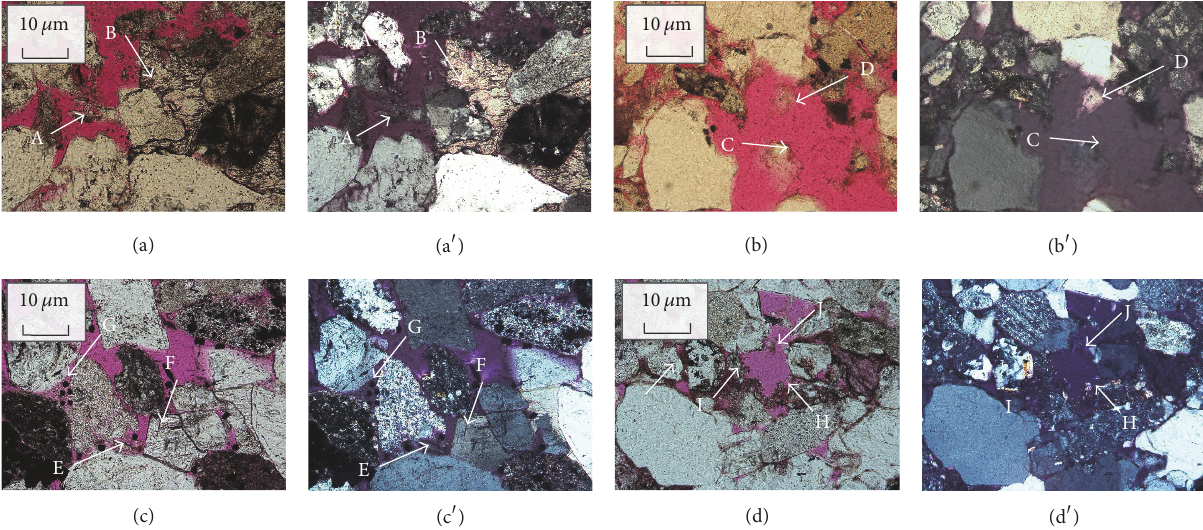
Figure 10: Photomicrographs of pore types by electron microprobe analysis of sandstones in central Junggar Basin. (a) and (a 󸀠 ) Intergranular secondary pore develops, and measuring point A shows that the remnant is K-feldspar and the measuring point B is calcite. The photomicrograph is a red-epoxy-impregnated thin sections of conventional core samples with magnification of 10 (Sha 1 well at 3656.6 m with Jurassic) and photo (a) by plane-polarized light and photo (a 󸀠 ) by cross polarization; (b) and (b 󸀠 ) intergranular secondary pore develops, and measuring point C shows that the remnant is albite and measuring point D is K-feldspar. The photomicrograph is a red-epoxy-impregnated thin sections of conventional core samples with magnification of 10 (Zhuang 1 well at 4375.23 m with Jurassic), and photo (b) by plane- polarized light and photo (b 󸀠 ) by cross polarization; (c) and (c 󸀠 ) intergranular secondary pore develops, measuring point E shows that the remnant is albite. Measuring point F is calcite and measuring point G is siderite, and the photomicrograph is a red-epoxy-impregnated thin sections of conventional core samples with magnification of 10 (Sha 2 well at 3439 m with Jurassic) and photo (c) by plane-polarized light and photo (c 󸀠 ) by cross-polarized light; (d) and (d 󸀠 ) intergranular secondary pore develops, and measuring point H shows that the remnant is calcite, measuring point I is K-feldspar, and measuring point J is albite. The photomicrograph is a red-epoxy-impregnated thin sections of conventional core samples with magnification of 10 (Y1 well at 5877 m with Jurassic) and photo (d) by plane-polarized light and photo (d 󸀠 ) by cross-polarized